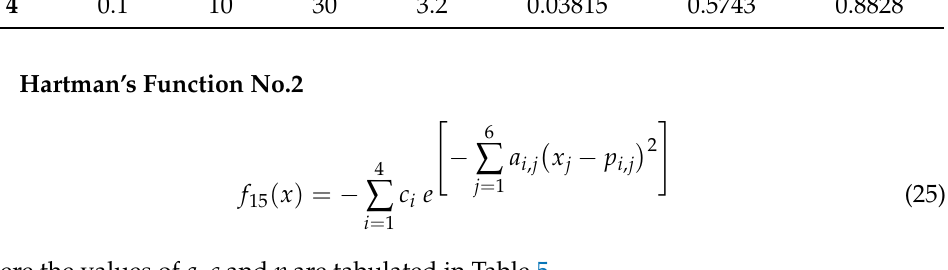
where the values of a , c and p are tabulated in Table 5. Table 5. Values of a ij , c i , and p ij for function f 1 5(x); n = 6 and j = 1, 2, ...,